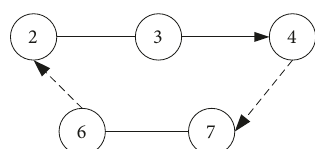
Figure 12: A chromosome of block transportation scheduling ( 𝑛 =10).